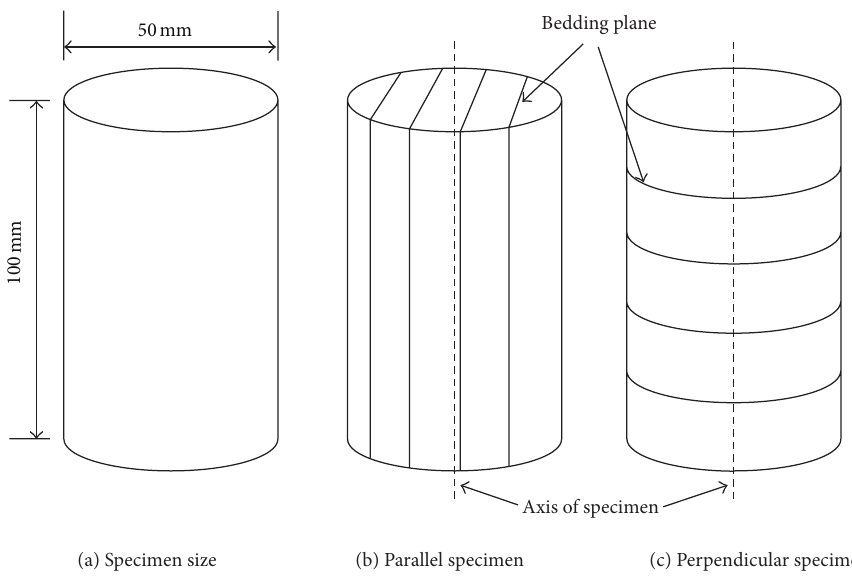
Figure 1: Schematic diagram of the coal